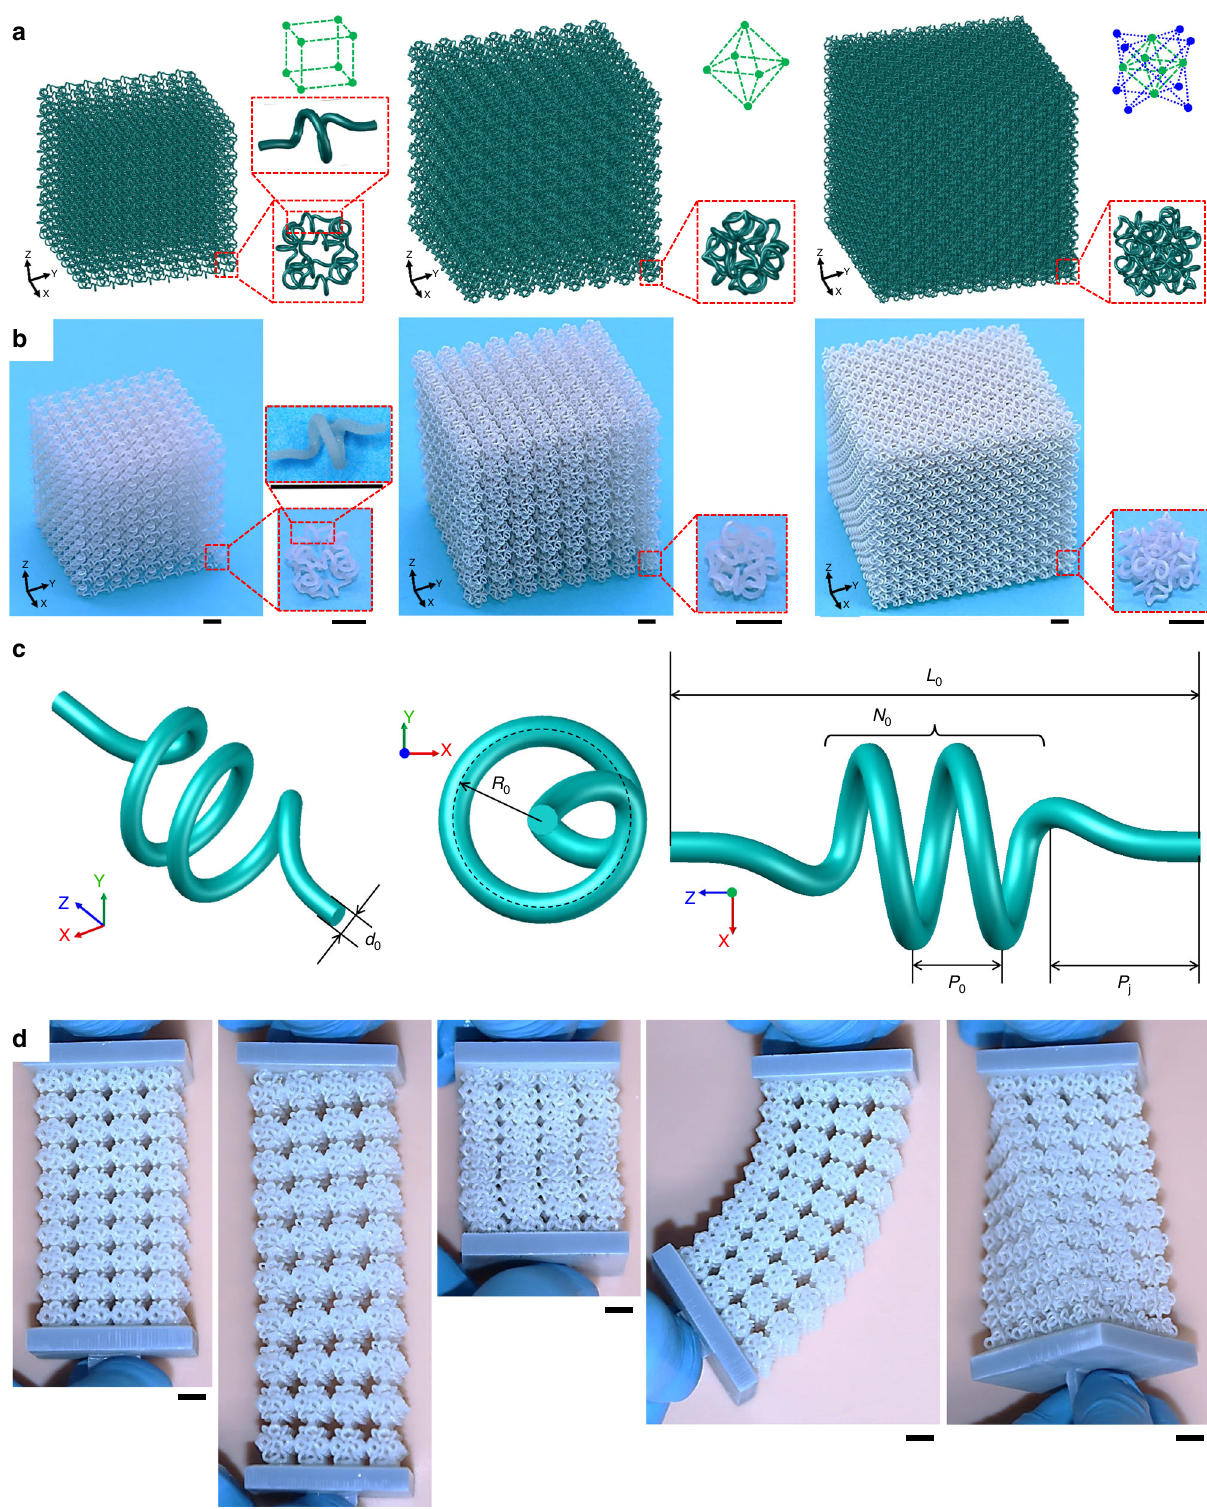
Fig. 1 Design and manufacture of soft 3D network materials. a Conceptual illustration of the microstructure design for soft 3D network materials with three different lattice topologies (from left to right: cubic, octahedral, and octet). The fi lamentary microstructure with a 3D helical con fi guration serves as the building block that connects the lattice nodes. b Optical images of the specimens fabricated using the polyjet 3D printing technique, according to the designs in a . Each specimen consists of 8 × 8 × 8 unit cells. c Schematic illustration of the geometric parameters associated with the 3D helical microstructure. d 0 , R 0 , N 0 , p 0 , and p j denote the diameter of the fi ber, the radius of the helix, the number of the coil, the pitch, and the joint length, respectively. d Optical images of a representative soft 3D network structure before and after large levels of deformations (stretching, compression, bending, and twisting). This structure is composed of 4 × 4 × 10 unit cells, each with an octahedral lattice topology. Scale bars, 5 mm in b and d